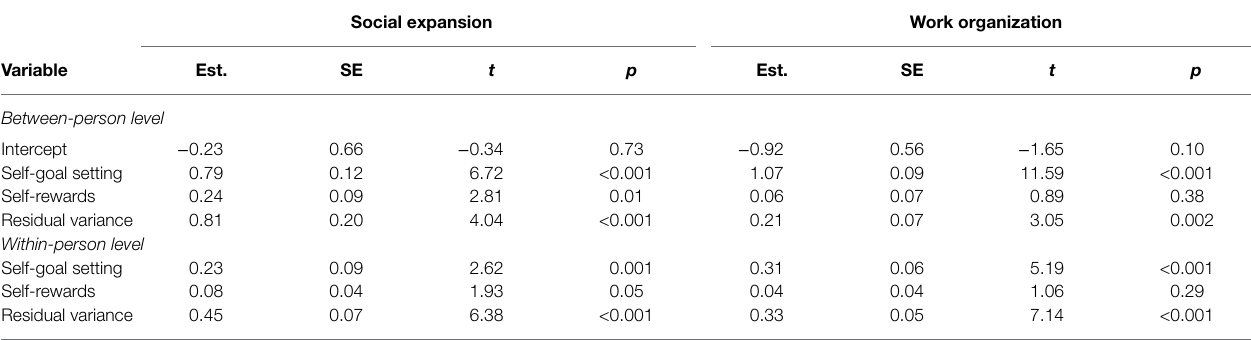
TABLE 2 | Unstandardized coefficients from multilevel path modeling predicting social expansion and work